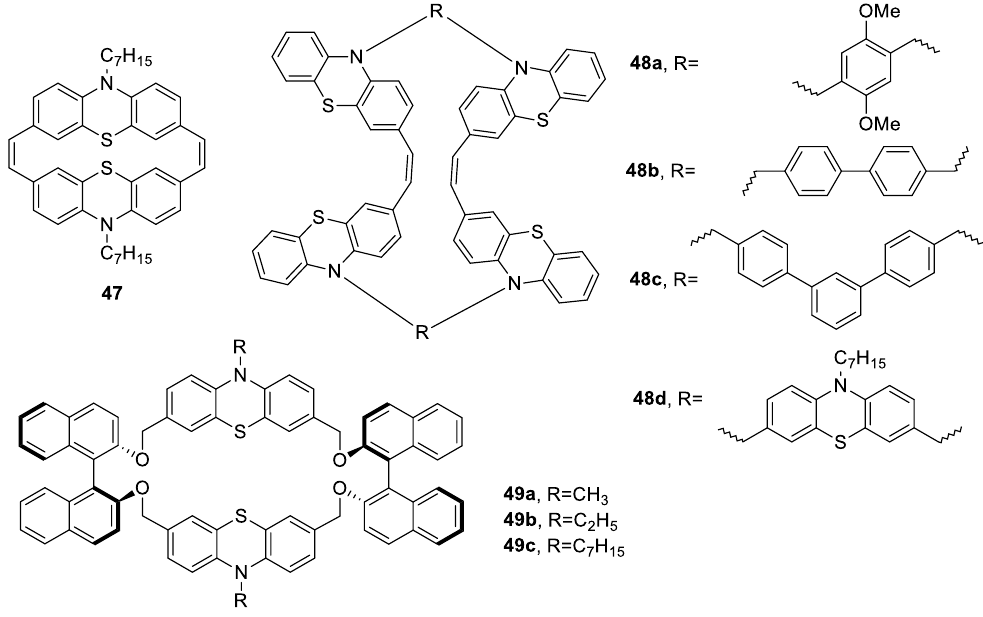
Figure 12. Structures of phenothiazinophanes from Kanagalatha et al. (2015) [87].